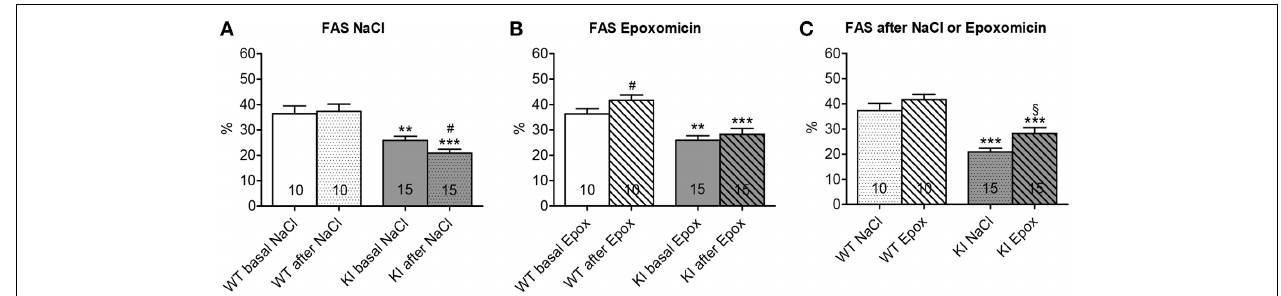
FIGURE 4 | Evaluation of cardiac function after proteasome inhibition in KI vs. WT mice. Fractional area shortening (FAS) was determined by echocardiography in KI (gray) and WT (white) mice under basal conditions (basal; plain; A, B ) or after 1 week of treatment with epoxomicin (Epox; stripes; B, C ) or sodium chloride (NaCl; dots; A, C ) via osmotic minipumps.